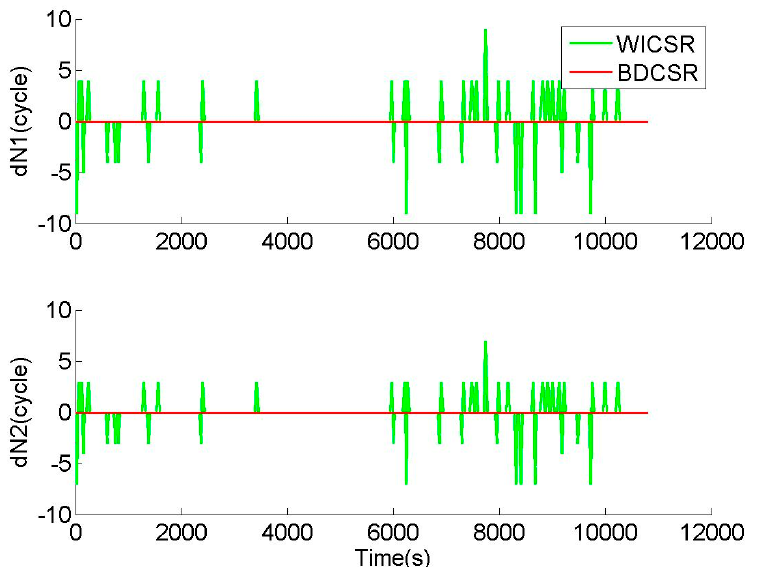
Figure 7. The original cycle slips of WICSR without correcting the ionospheric variations and those of the BDCSR methodology after correcting the ionospheric variations, where the BDS dual- frequency pseudoranges and phases without cycle slip were collected from the IGSO Satellite 6 during the geomagnetic storm, started from UTC 8 May 2016 00:00:00 with an interval of 30 s at the CUT0